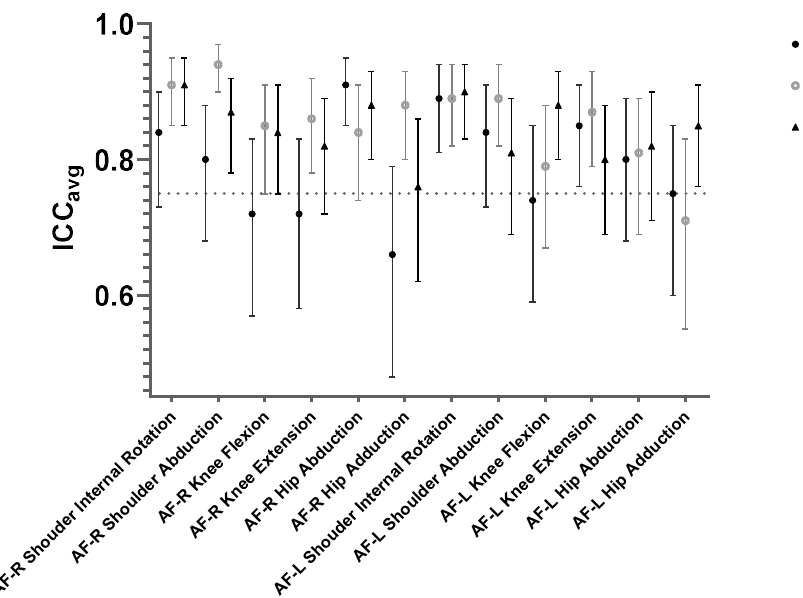
Figure 3. Relative interrater reliability of EasyForce for the right and left side.